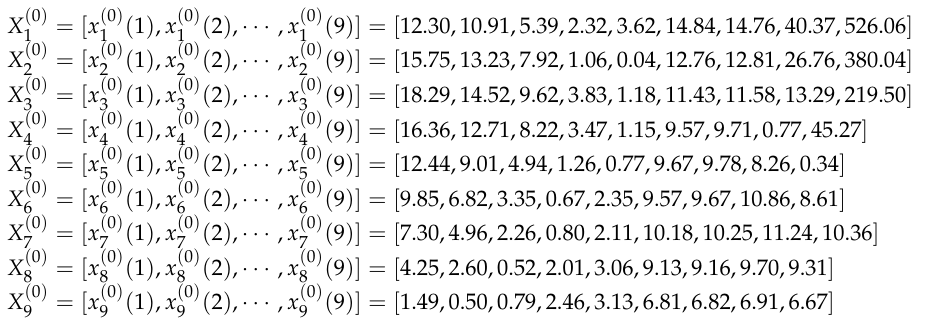
Figure 12. Curve of accumulative deformation. ( a ) Graph of cumulative horizontal displacement